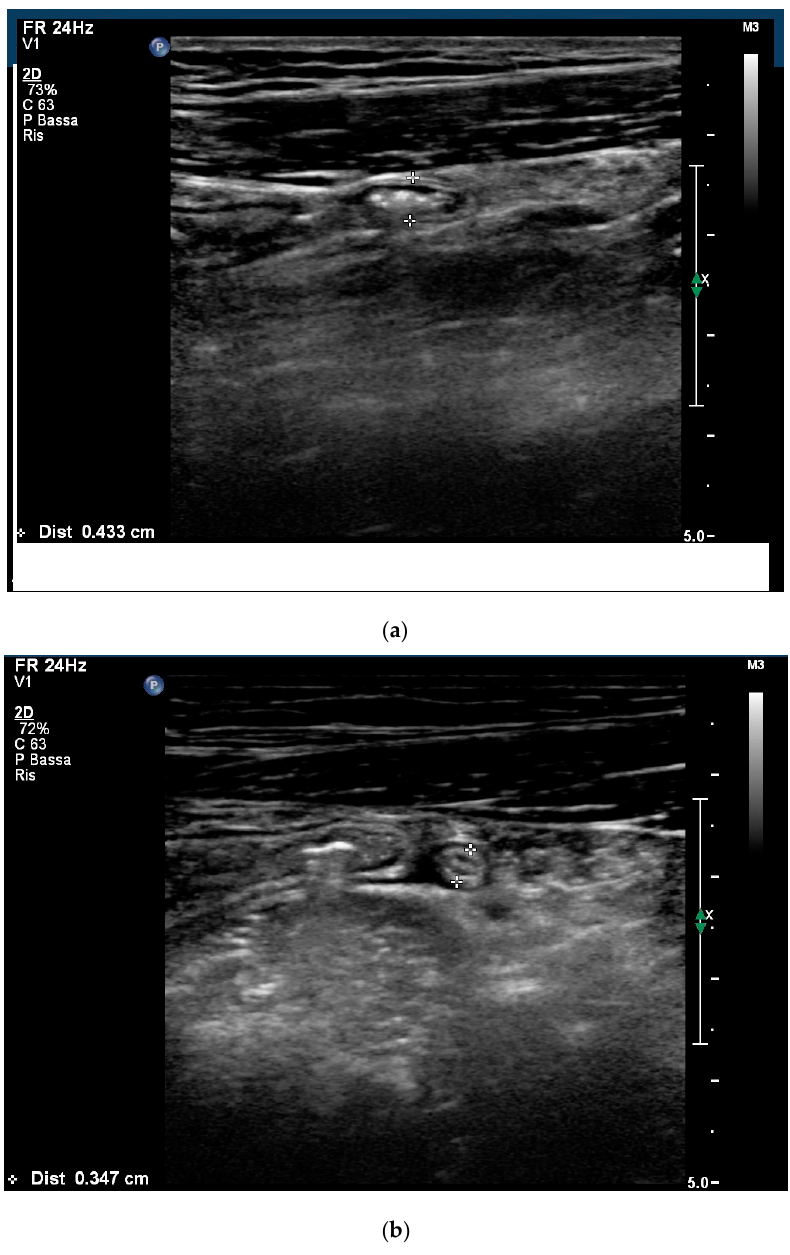
Figure 3. ( a ) Longitudinal and ( b ) transverse real-time ultrasound scan of the right lower quadrant performed with a high-frequency transducer (5–12 MHz), showing the complete resolution of appendicular inflammation with disappearance of any free abdominal